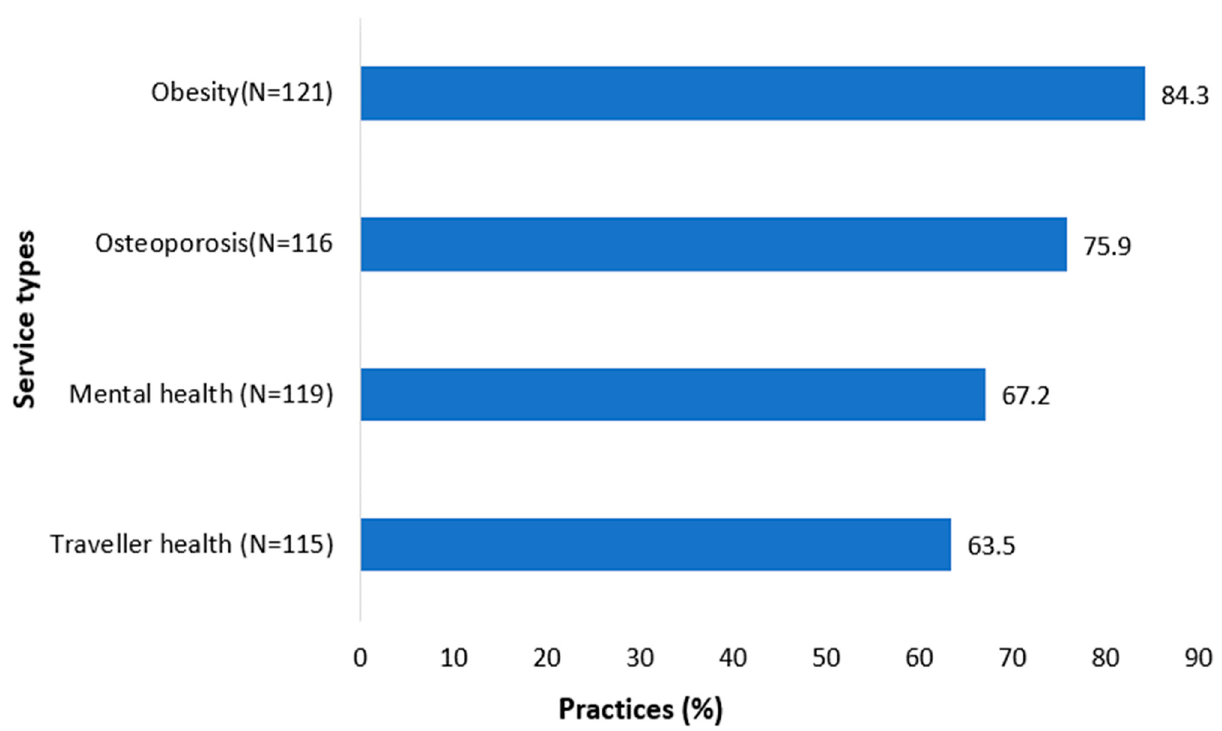
Figure 4. Agreement on the expansion of other health services to HSE CDM programme in general practice.